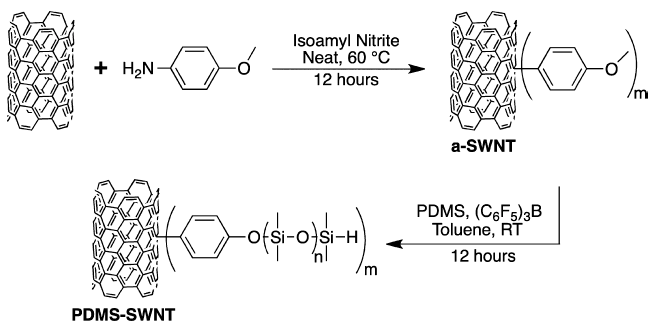
Figure 9. Preparation of polydimethylsiloxane (PDMS)-SWNT by PR reaction after functionalization of single-walled carbon nanotubes (SWNTs) [53]. Reprinted with permission from Macromolecules 2014